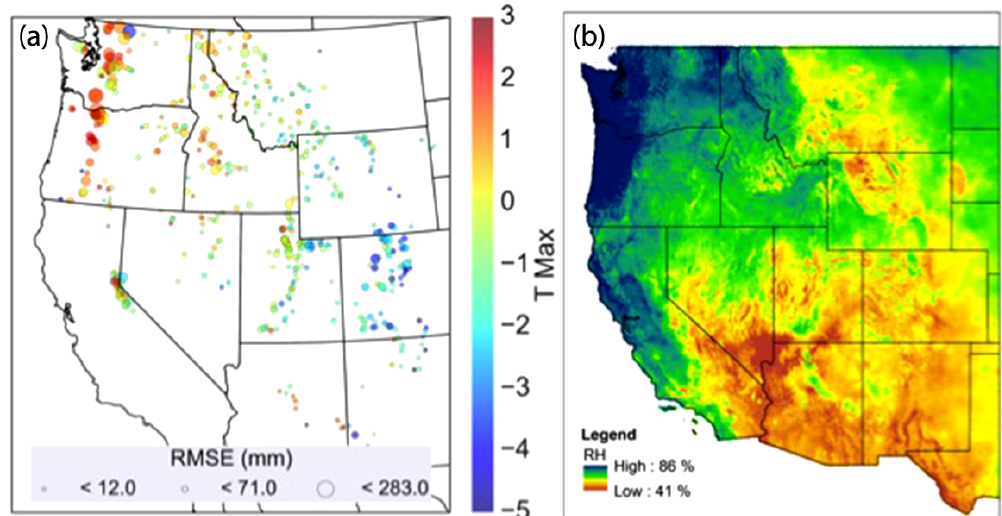
Figure 3. The optimized critical maximum daily temperature threshold that produced the lowest root mean square error (RMSE) in the prediction of snowfall at Snow Telemetry (SNOTEL) stations across the western USA (adapted from Rajagopal and Harpold, 2016). (b) Precipitation-day relative humidity averaged over 1981–2015 based on the Gridmet dataset (Abatzoglou,